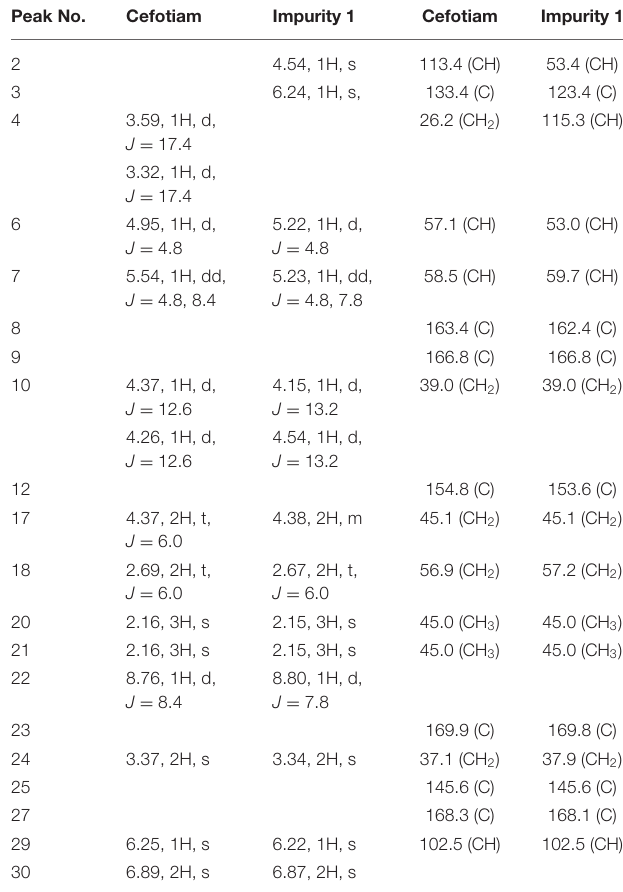
TABLE 3 | NMR data for cefotiam and impurity 1 in DMSO- d 6a . Peak